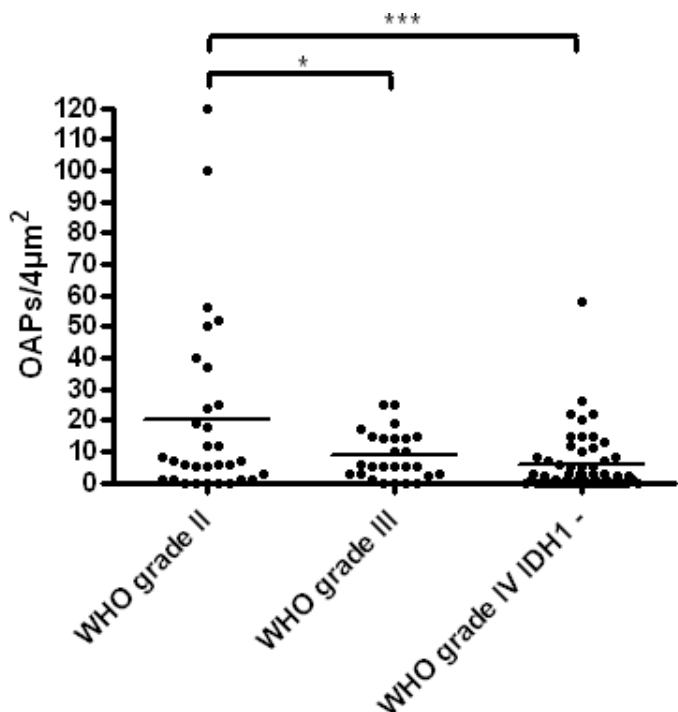
Figure 2. Number of OAPs counted per 4 µm 2 in astrocytoma WHO grade II, III and IV IDH1-negative glioblastoma. The number of OAPs in astrocytoma WHO grade II is significant higher than in astrocytoma WHO grade III ( p = 0.028) and glioblastoma ( p = 0.0006). * p ≤ 0.05, *** p ≤ 0.001.